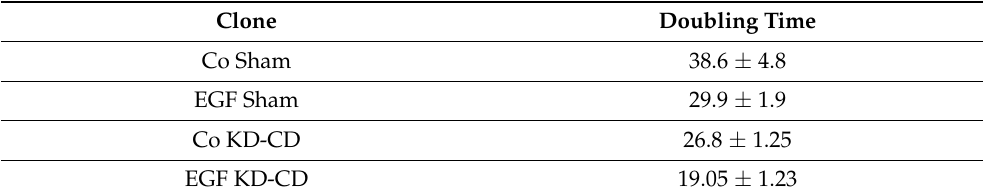
Table 2. Doubling time calculated for SH-SY5Y Sham and KD-CD